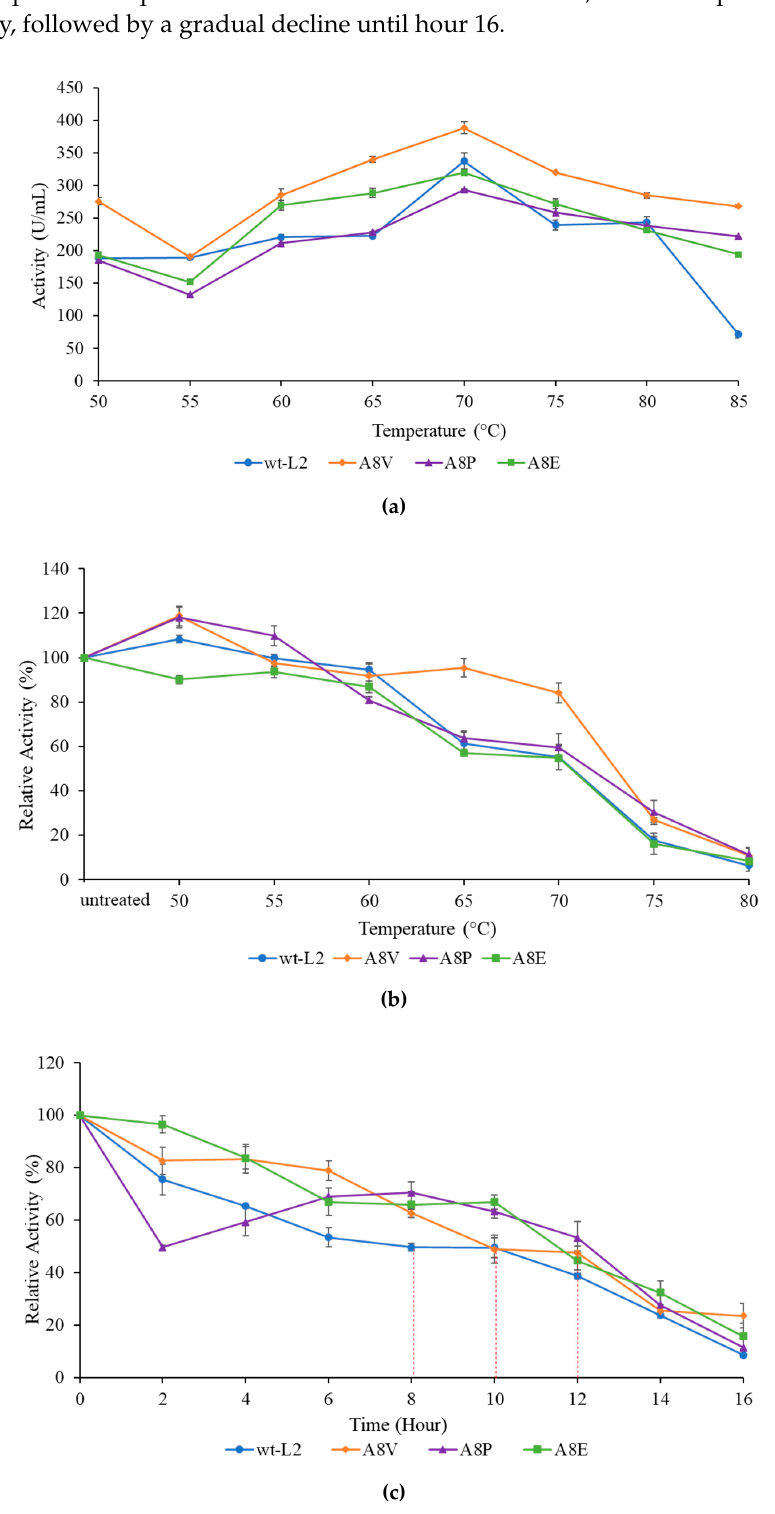
Figure 6. The activity profile of wt-L2 and mutants A8V, A8P and A8E. ( a ) The optimum temperature profile, ( b ) The thermostability profile and ( c ) The half-life profile. The relative activity was measured against untreated lipases and assumed to be 100%.